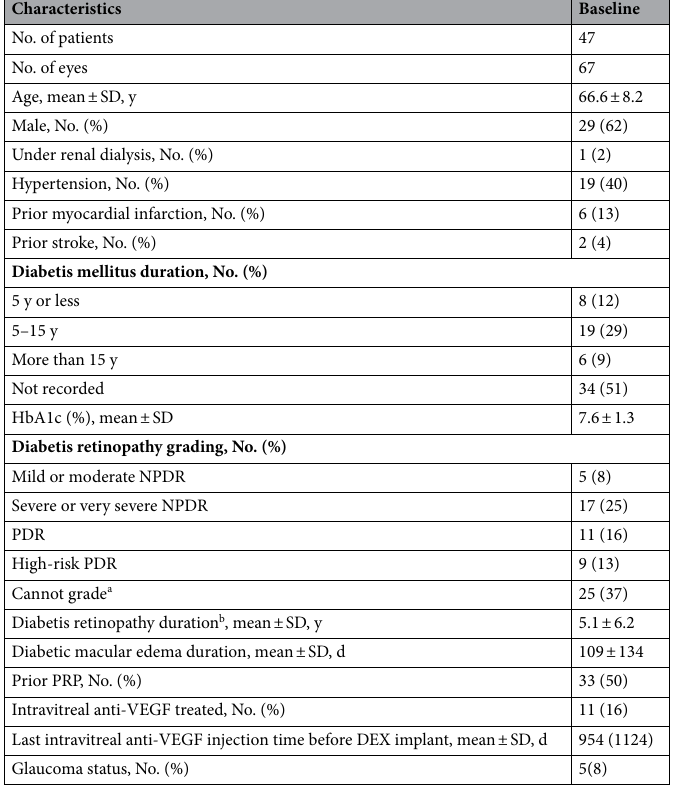
Table 2. The interrater reliability for biomarker gradings was moderate (interclass correlation coefficient: 0.56, 95% CI, 0.44–0.66). Forty-one eyes (62%) had CFT over 390 µm, 20 (30%) had severe IRC, and 14 (21%) had SRF in the fovea. The majority (63%) of the eyes had an intact EZ; however, DRIL was present in 74%. HRD was graded as abundant (higher than 30 dots) in nearly half of the eyes (45%). Half of the eyes (49%) had an epiretinal membrane. Combining the CFT, IRC, EZ, and DRIL status, the resulting DME staging was: early (17%), advanced (57%), and severe (12%) DME. Fundus photographic grading showed that 22 eyes (33%) had moderate or severe HE at baseline.